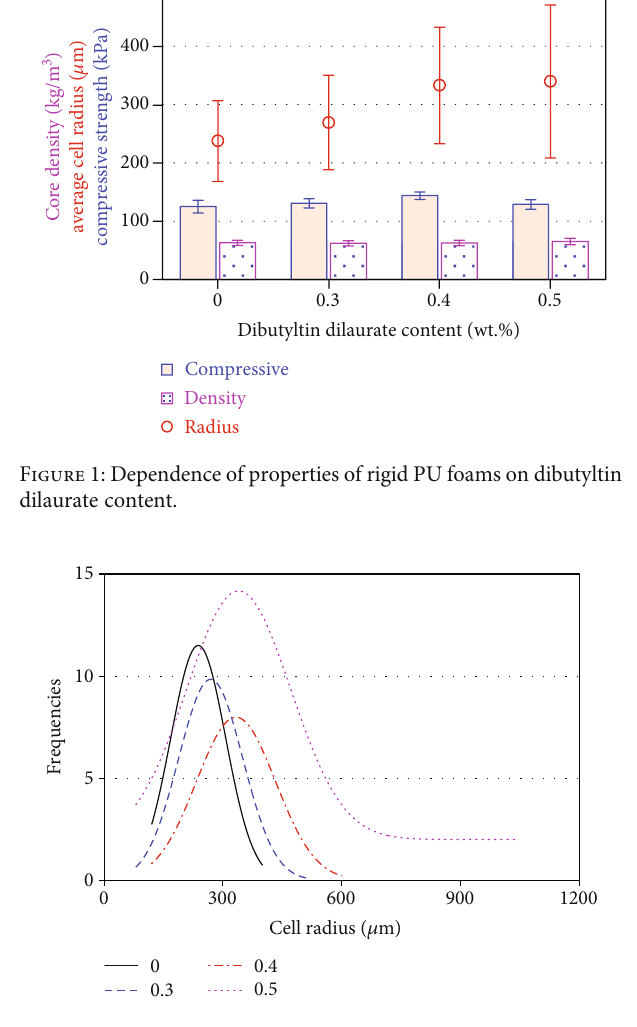
Figure 2: Dependence of the pore size distribution on dibutyl dilaurate